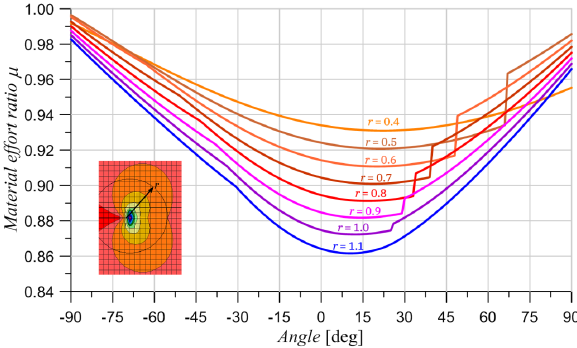
Figure 20: Values of material effort ratio for different angles and different distance from the crack